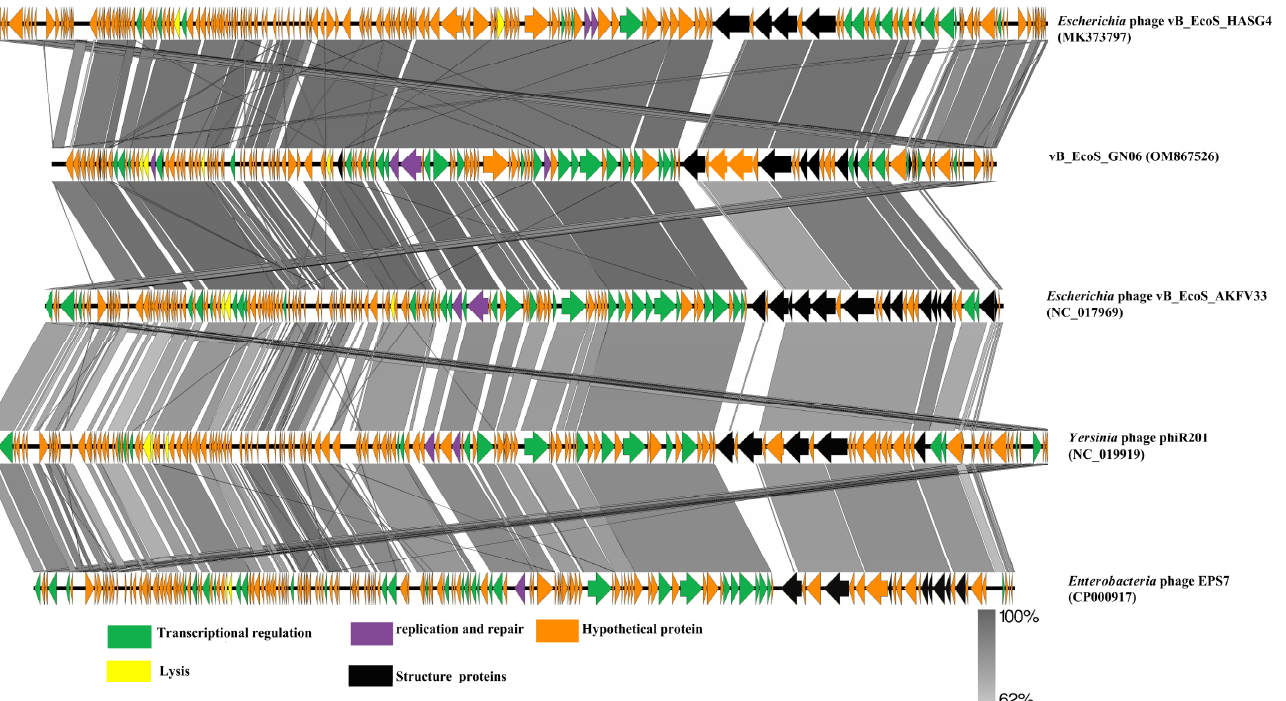
Figure 6. Comparative analysis of five phages was conducted using Easyfig, with nucleotide identity above 62%. Well-conserved segments were paired by shaded regions, and arrows indicated the direction of transcription for the predicted CDSs.